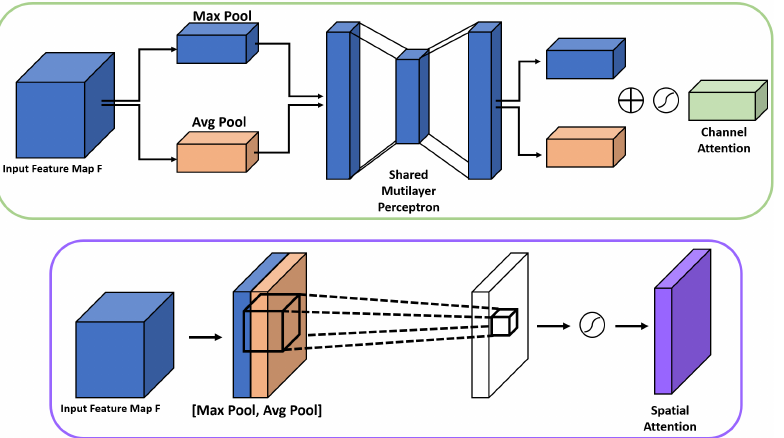
Figure 3. Channel and spatial attention method for CBAM. Each attention method used max-pooling and average-pooling to extract information from the object from the feature map and then attention to extract the important information of the channel through the sigmoid